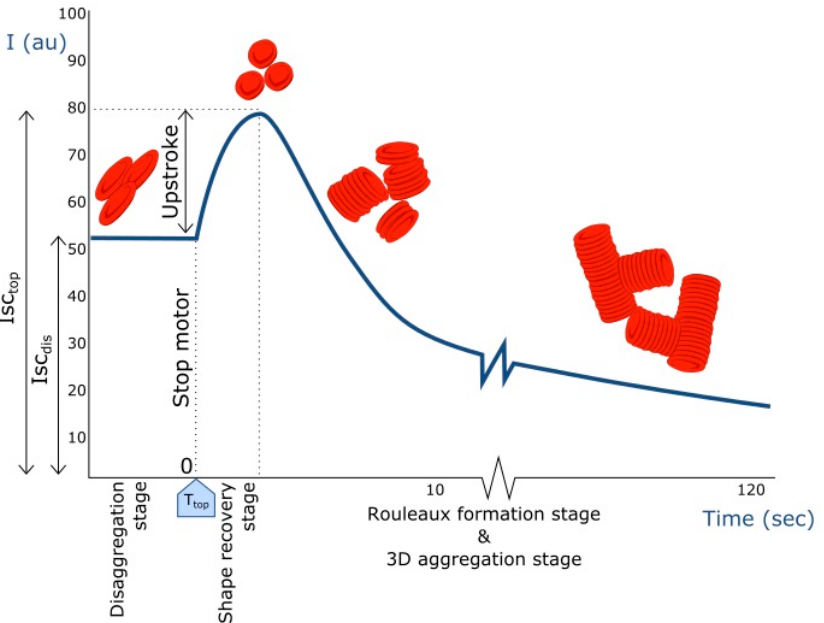
Figure 1. Syllectogram of red blood cell (RBC) aggregation: The intensity of laser backscatter (Isc) plotted versus time before and after a sudden stop of the motor. RBC morphology, corresponding to the various parts of the curve, is indicated (see text).